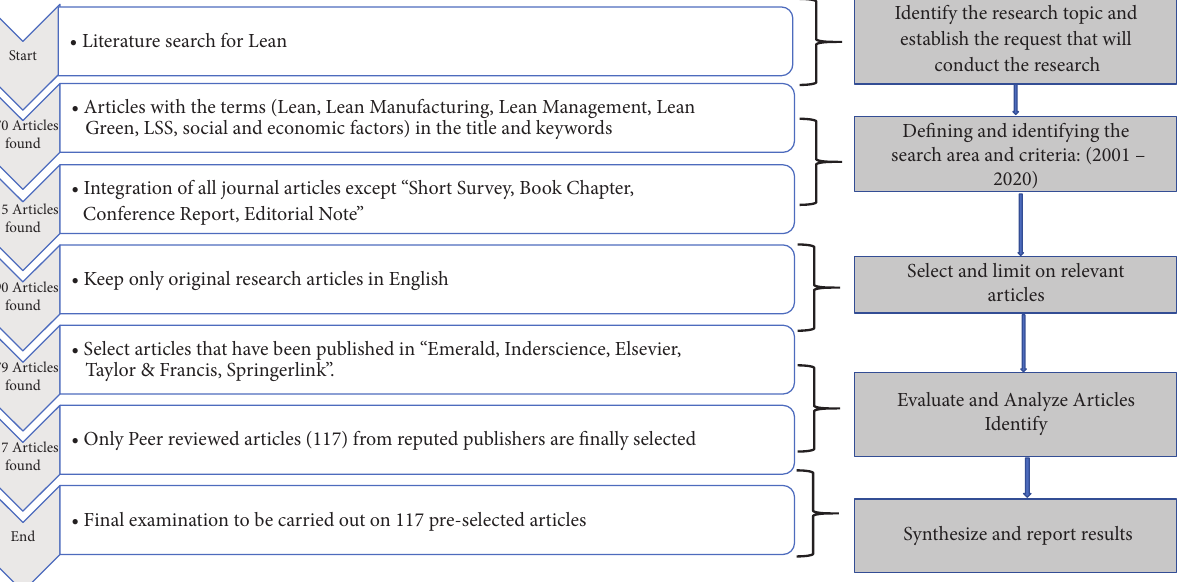
Figure 4: Main stages of the adopted research for the literature review.